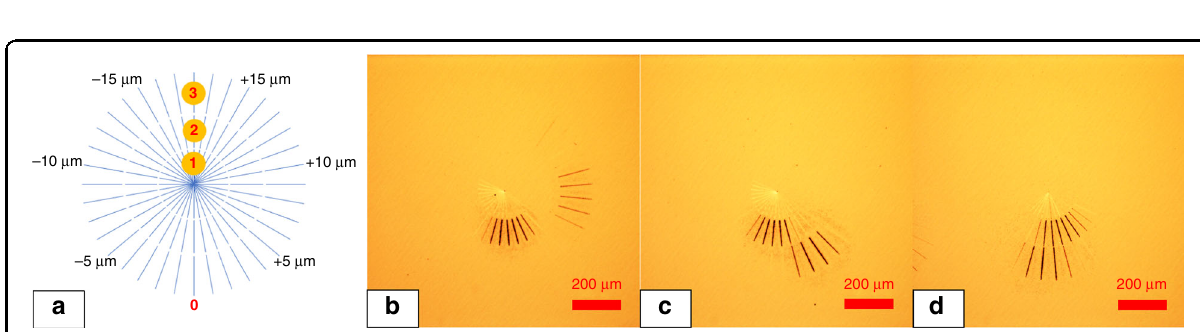
Fig. 11 Laser beam processing strategy to quantify and correct the spherical aberration